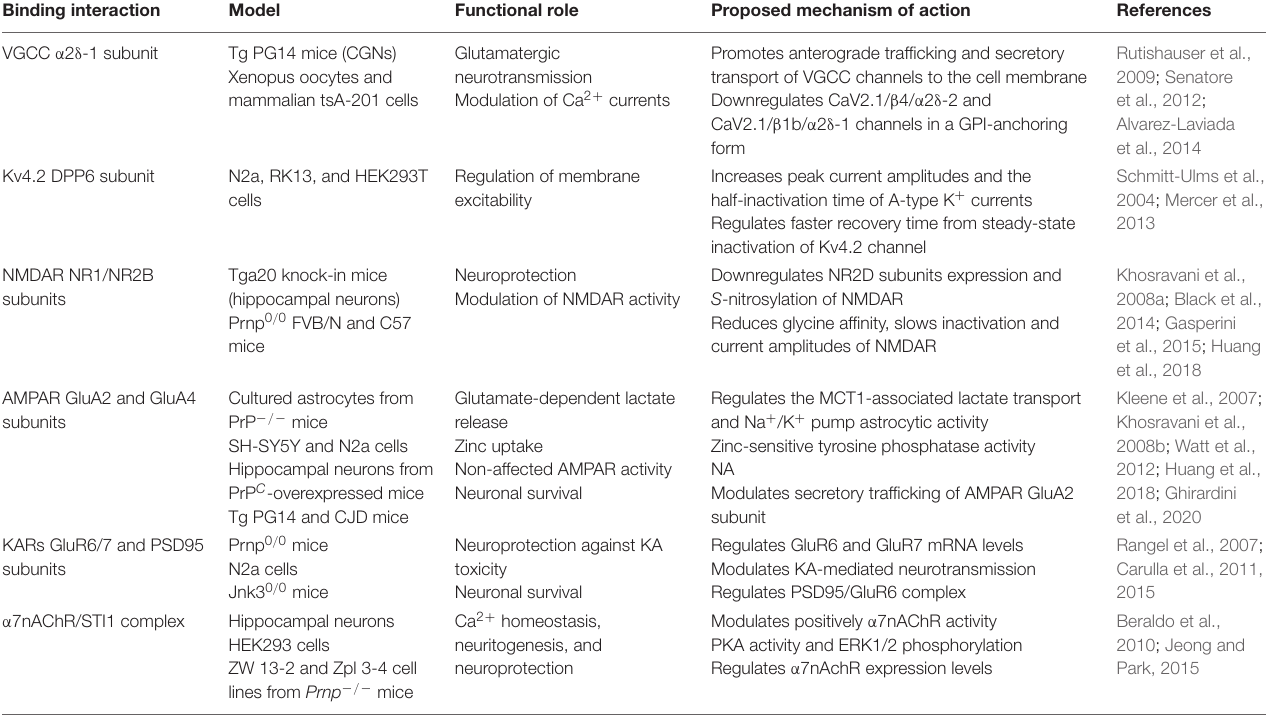
TABLE 1 | Summary of the main effects of PrP C in synaptic